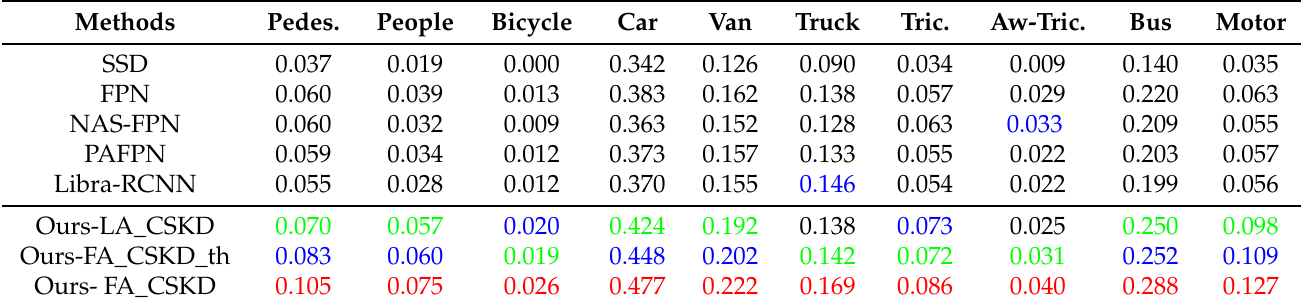
and bus with larger sizes have the better average accuracy, while small object categories such as people and pedestrian have worse accuracy. Our proposed approach is superior to the other five mainstream methods in most categories (except truck and awning-tricycle). Table 5. Performance comparison between our method and other SOTAs on metric of average precision of each class. The top three methods are highlighted in red, blue, and green. Methods Pedes.